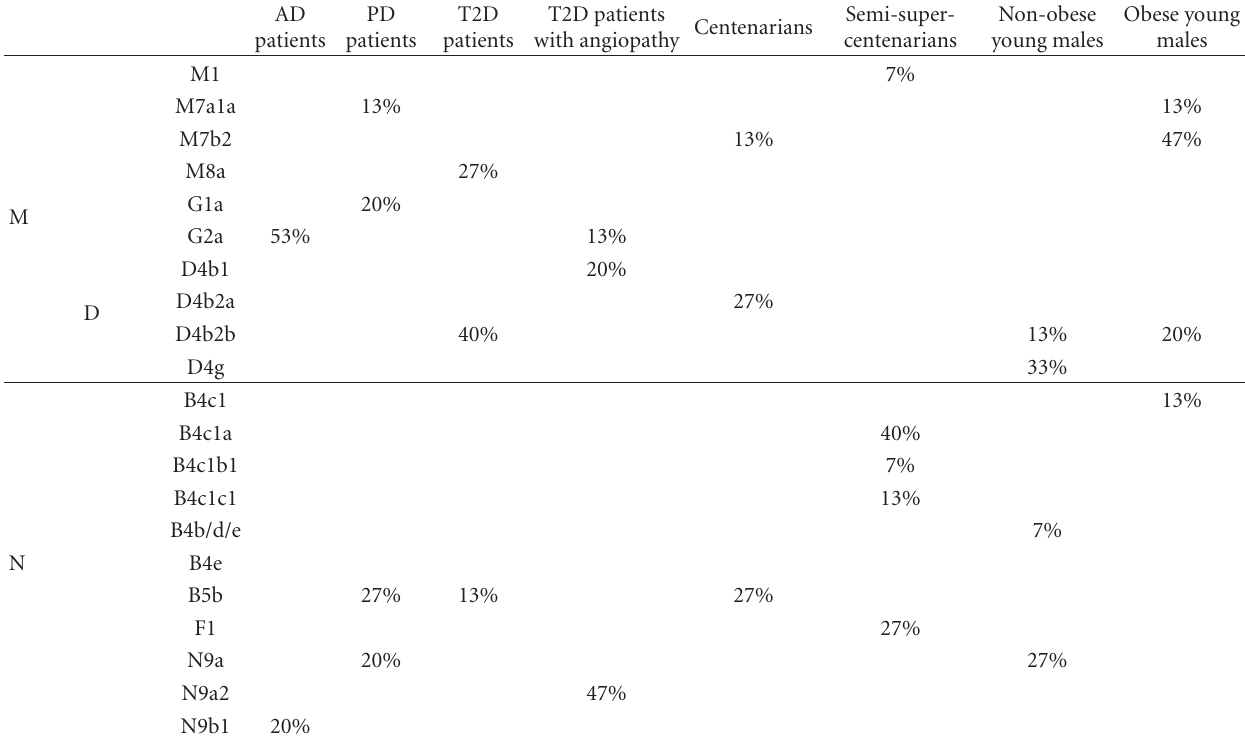
Table 2: Haplogroup-class relations determined using the 15 individuals with highest